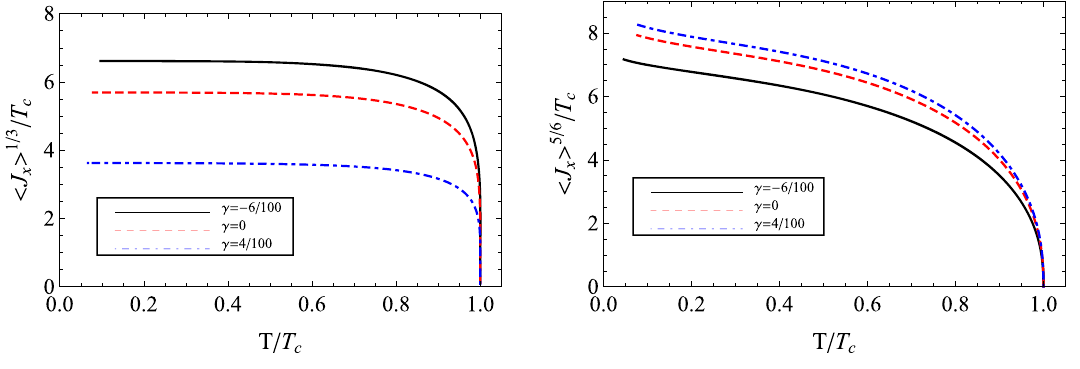
Fig. 1 The condensate versus the temperature with γ = − 6 z = 1 (the left panel) and z = 5